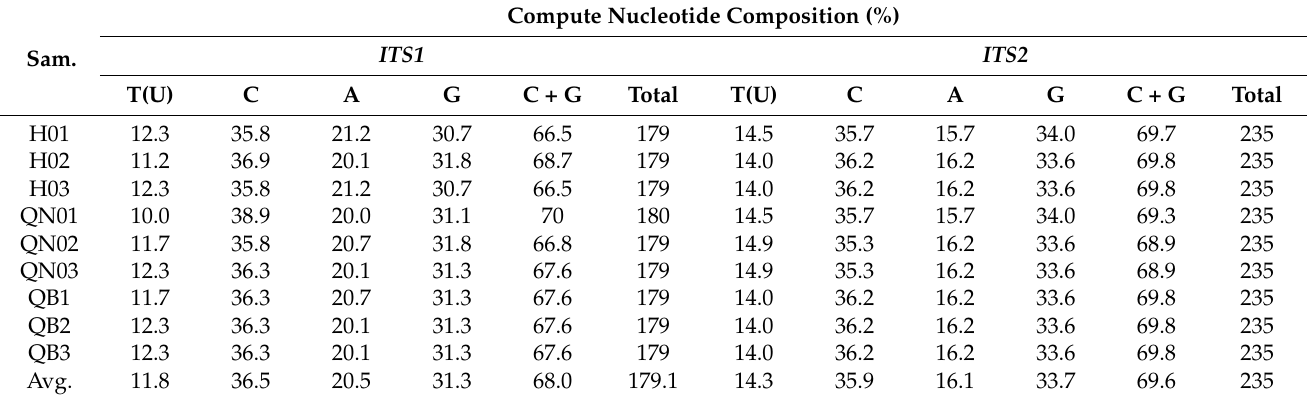
Table 7. Nucleotide components of the ITS1 and ITS2 gene regions of nine M. officinalis samples.